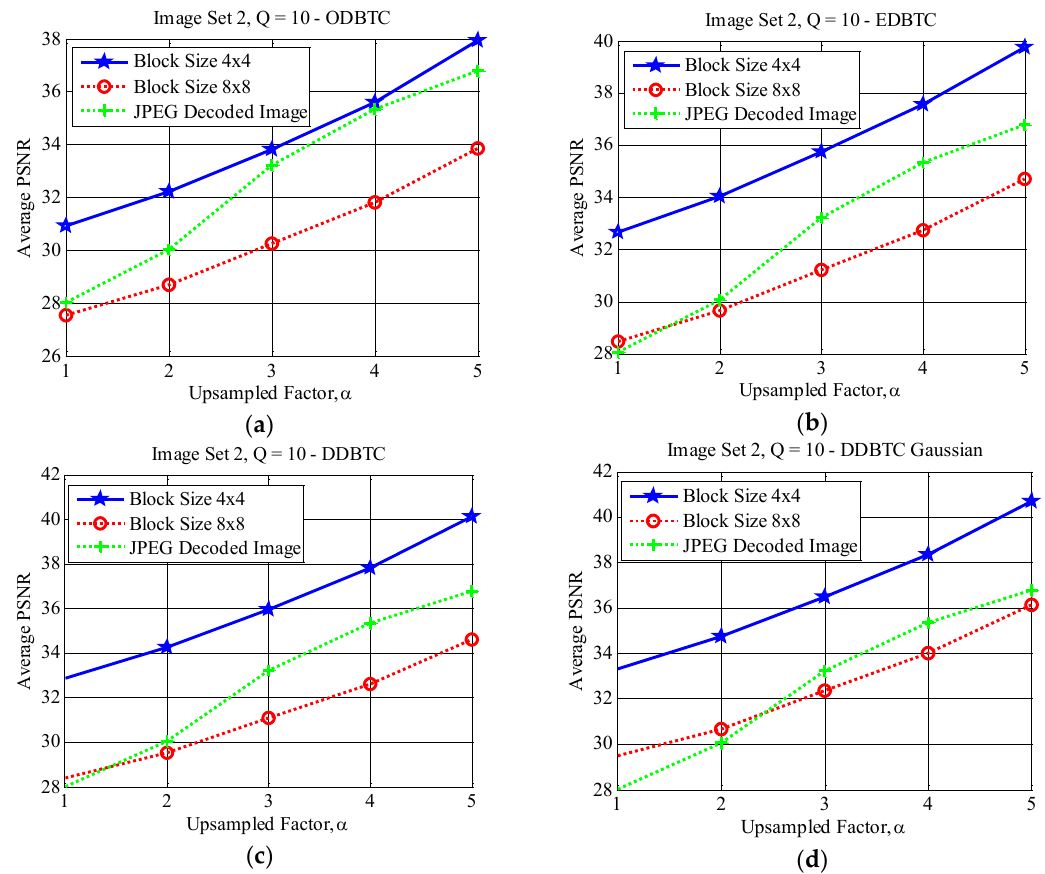
Figure 22. Effect of image block sizes on Image Set 2 with 𝑄 = 10 over ( a ) ODBTC; ( b ) EDBTC; ( c ) DDBTC; and ( d ) DDBTC Gaussian scheme.